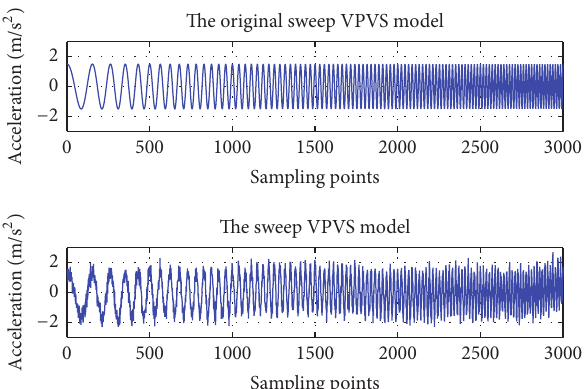
Figure 7: The original sweep VPVS model and sine VPVS model.